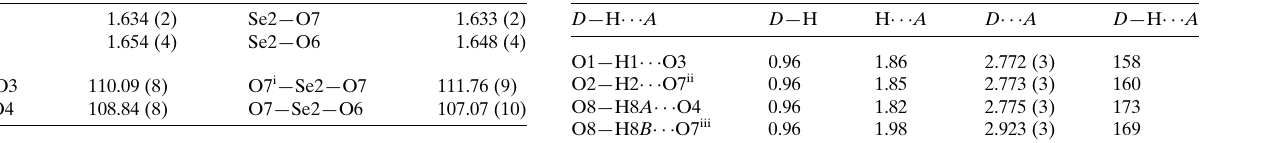
Table 1 Selected geometric parameters (A˚ , (cid:4) ).